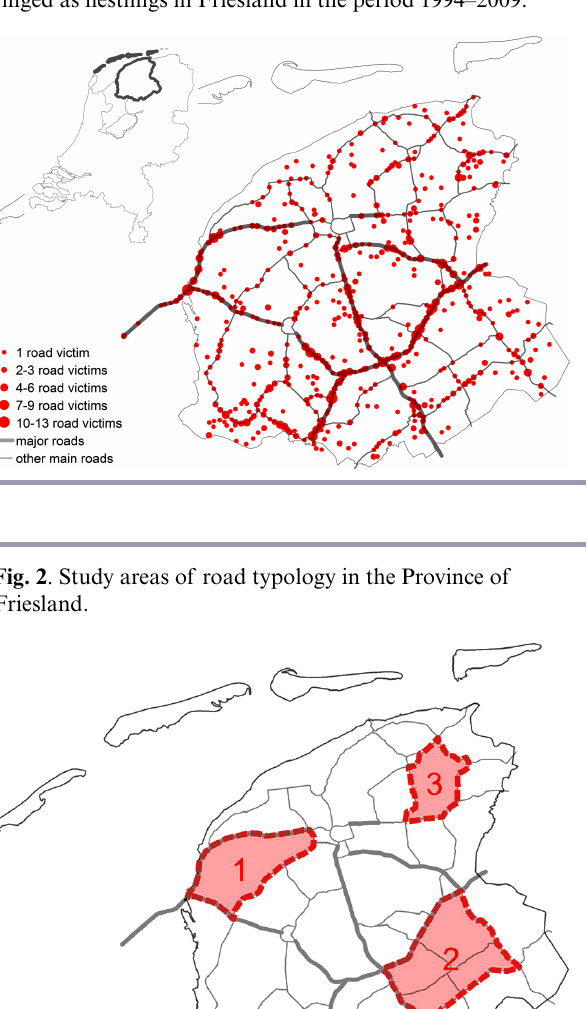
Fig. 1 . Distribution of 996 Barn Owl ( Tyto alba ) road casualties in the province of Friesland, all of which were ringed as nestlings in Friesland in the period 1994–2009.